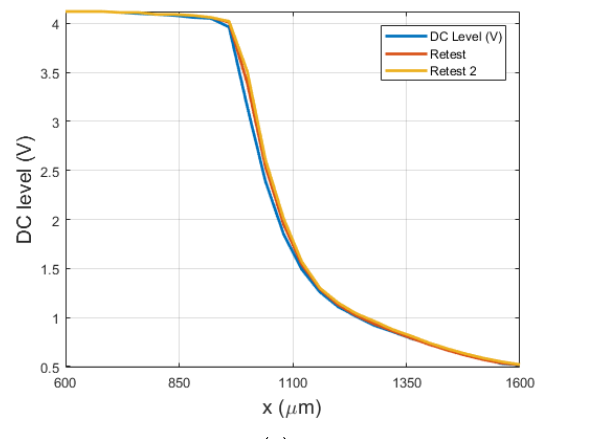
Figure 10. Beam with σ (mm) as a function of the axial beam coordinate z.